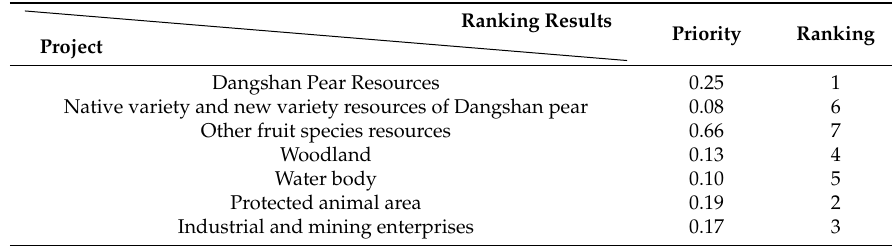
Table 4. Ranking results of government regulatory role.